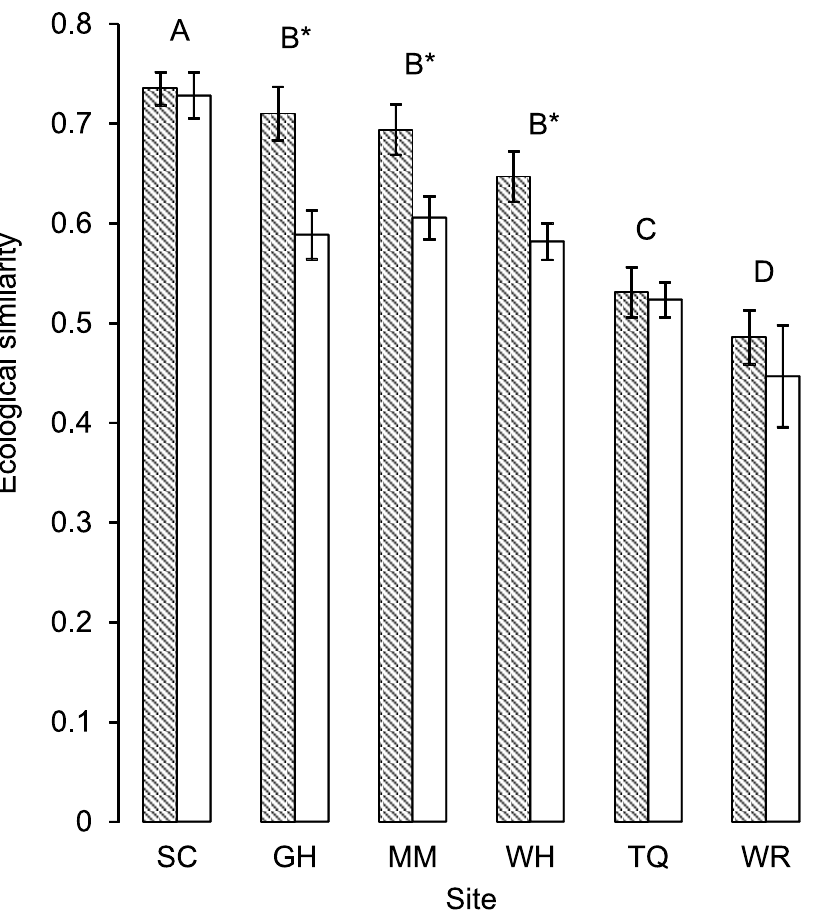
Fig 5. Ecological similarity of microsites within six reintroduction sites compared to microsites at Rocky Prairie. Different letters denote significant difference across sites ( α = 0.05), “ * ” denote prairies where ecological similarity was significantly different between where golden paintbrush was absent or present ( α =